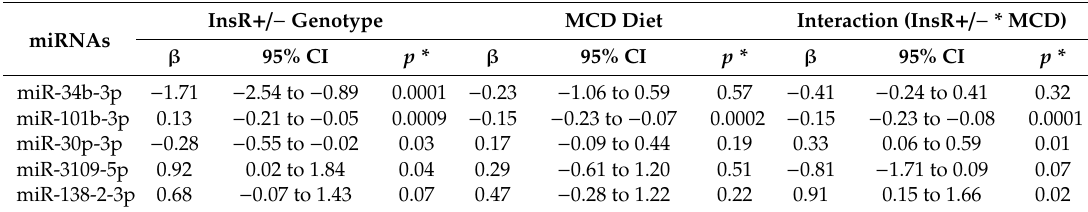
Table 1. Independent predictors of hepatic miRNA levels in wt and InsR +/ − mice fed a standard or MCD diet. miRNAs